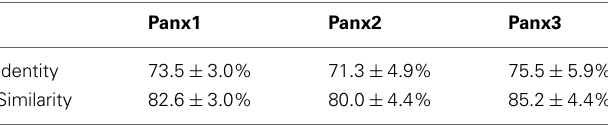
Table 1 | Amino acid conservation of Panx